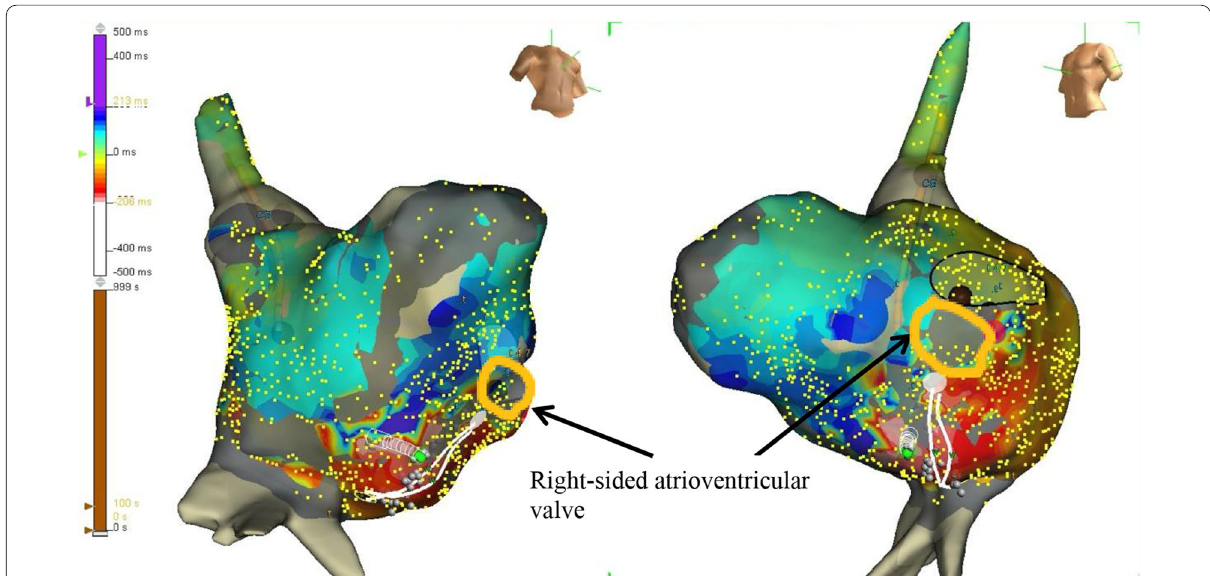
Fig. 6 The activation mapping of showed that AFL was using the isthmus between the right-sided atrioventricular valve and the inferior vena cava and a part of the Fontan circuit The patient had history of double-inlet single-ventricle heart with transposition of great arteries required several surgical repairs including Blalock shunt and classic Fontan procedure connecting right atrium to pulmonary